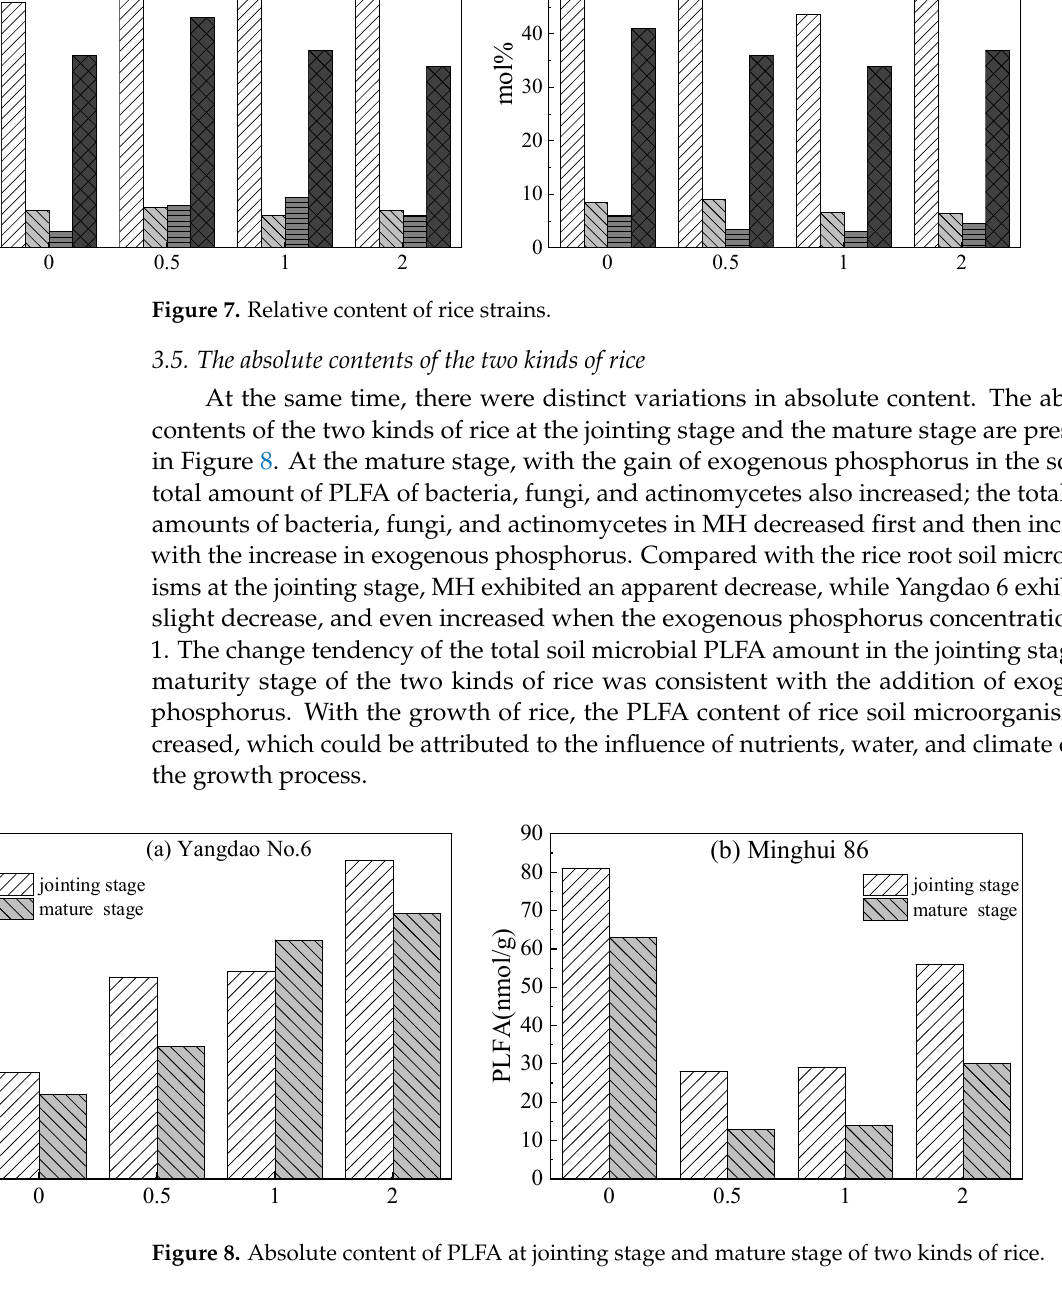
Figure 8. Absolute content of PLFA at jointing stage and mature stage of two kinds of rice.